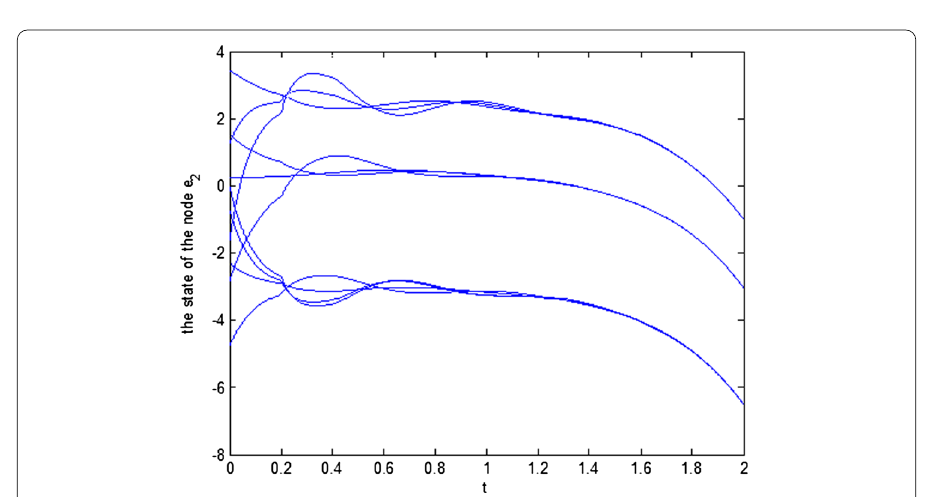
Figure 2 The state of the node e 2 without